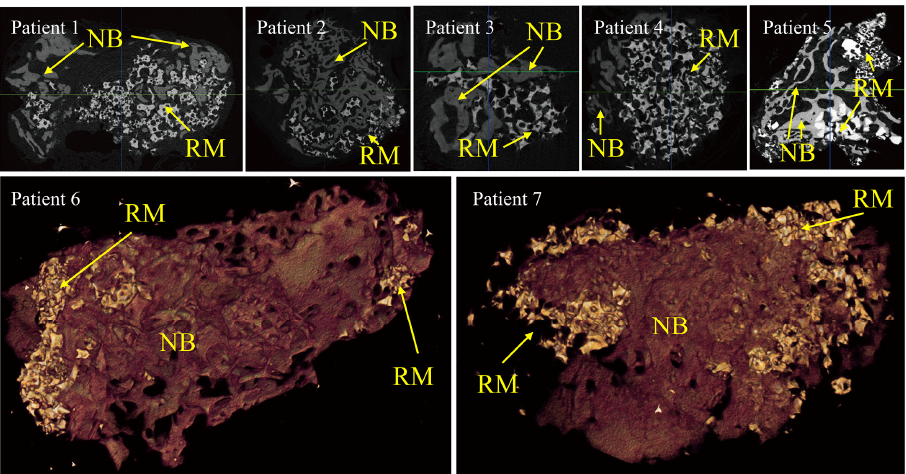
Figure 2. Micro-computed tomographic views of each case. Three-dimensional reconstructed images are provided for the samples from patients 6 and 7. NB indicates newly formed bone. RM indicates residual bone substitute material. In all specimens, the radio-opacity of residual bone substitute material is higher than that of newly formed bone.